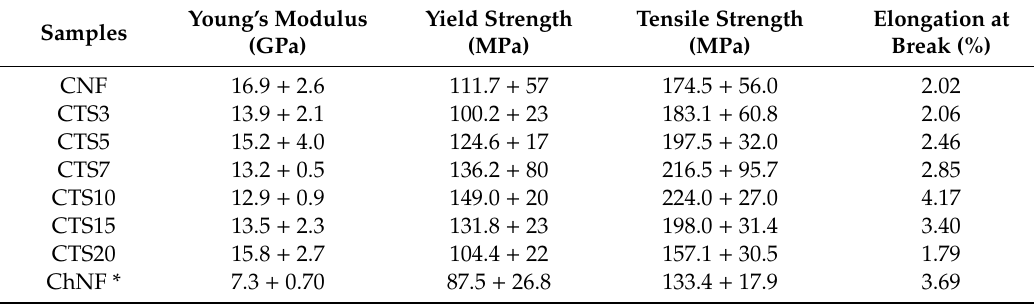
Table 1. Tensile test results of ChNF, CNF and their